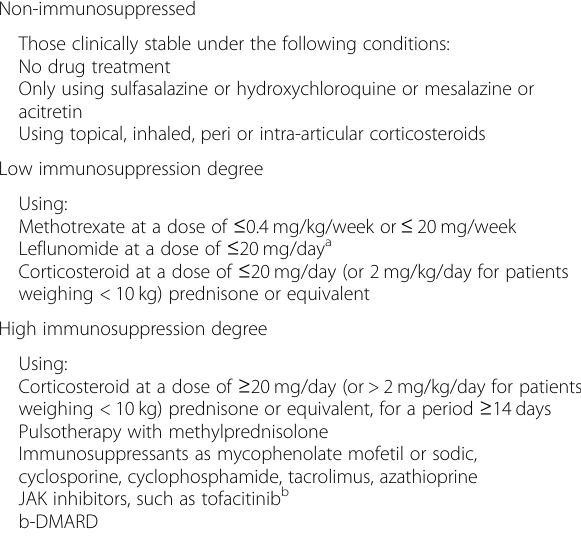
Table 3 Immunosuppression degree conferred by drugs used to treat patients with chronic immune-mediated inflammatory diseases: Positioning of the Brazilian Societies of Rheumatology, Dermatology and Study Groups on Inflammatory Bowel Diseases